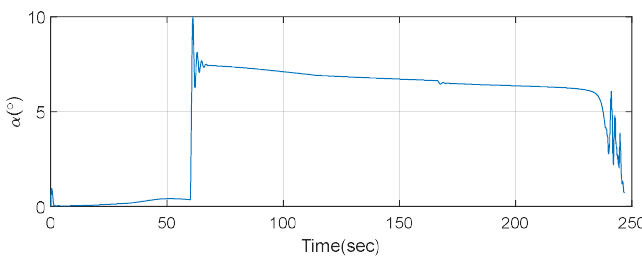
Figure 20. Altitude vs. Drift vs. Range.